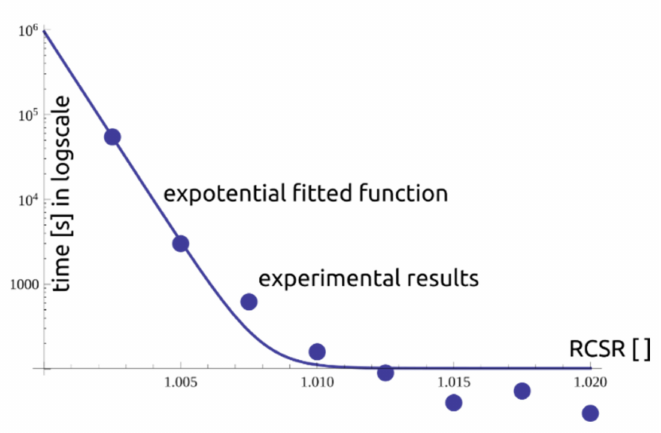
Figure 9. The dependency of RCSR vs. time.